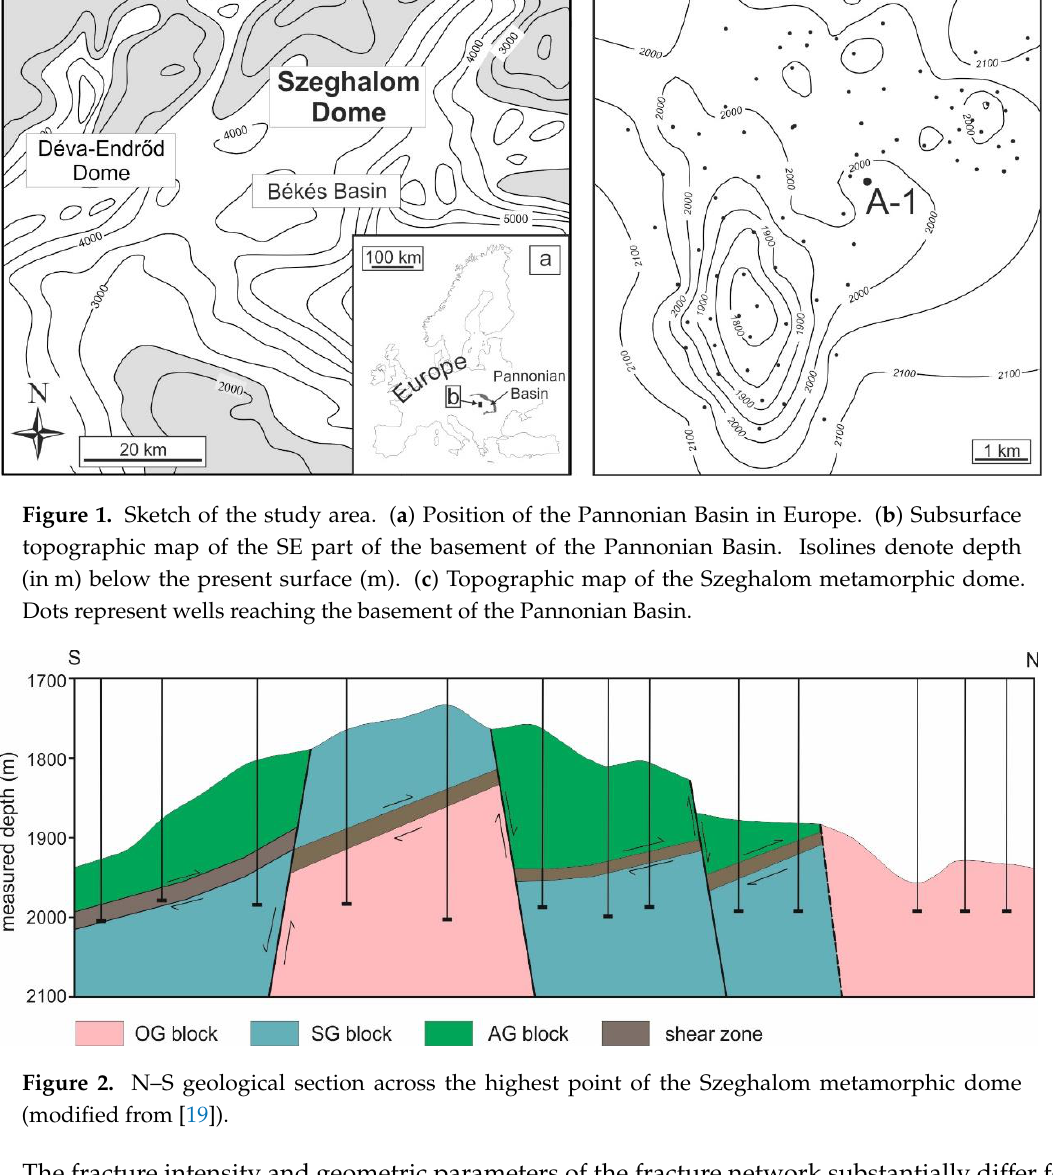
Figure 2. N – S geological section across the highest point of the Szeghalom metamorphic dome (modified from [19]) .